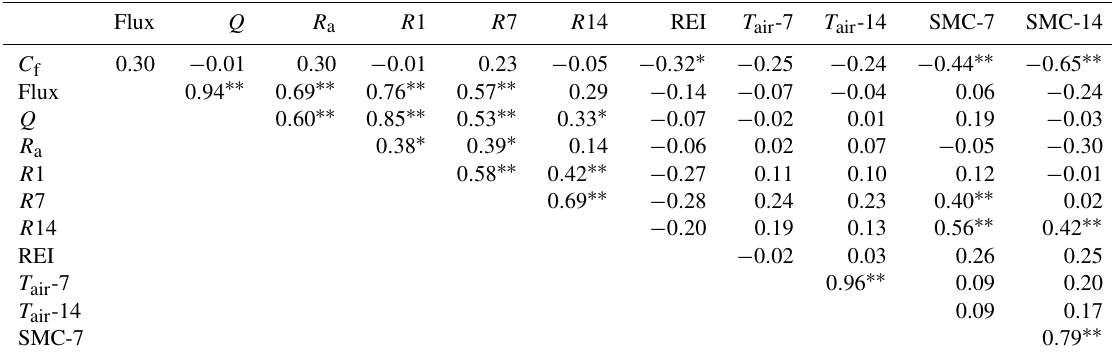
Table 2. Summary of correlation coefficients between C f , flux and a set of factors.